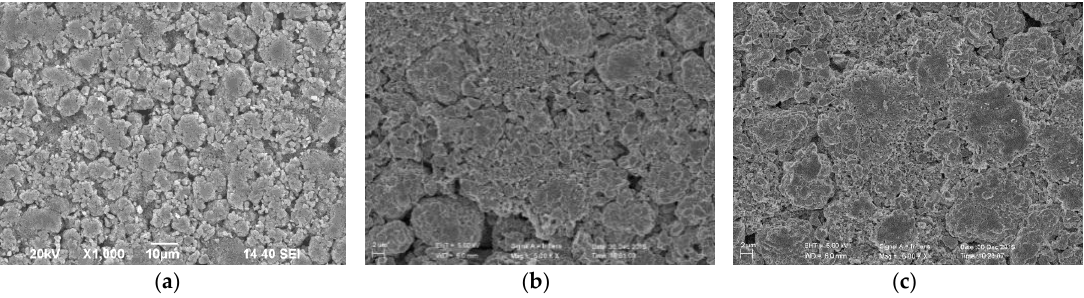
Figure 9. Scanning electron microscope (SEM) analysis before and after three cycles: ( a ) fresh NCM cathode electrode; ( b ) NCM cathode electrode cycled in baseline electrolyte; and ( c ) NCM cathode electrode cycled in safety electrolyte.